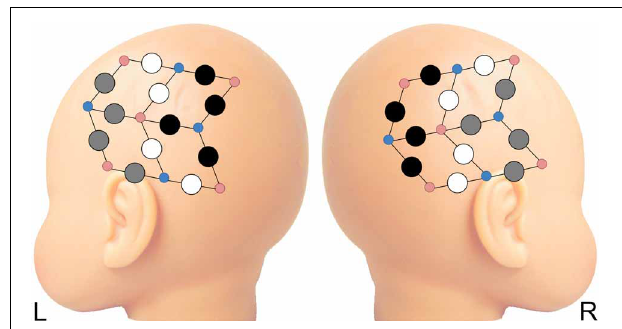
FIGURE 2 | Four regions of interest (ROI) selected from anterior and posterior recording sites on each hemisphere. Gray circles represent channels included in anterior ROIs; black circles are channels included in posterior ROIs. Probes not included in ROIs are depicted in white. Smaller red and blue circles represent infrared emitters and detectors,